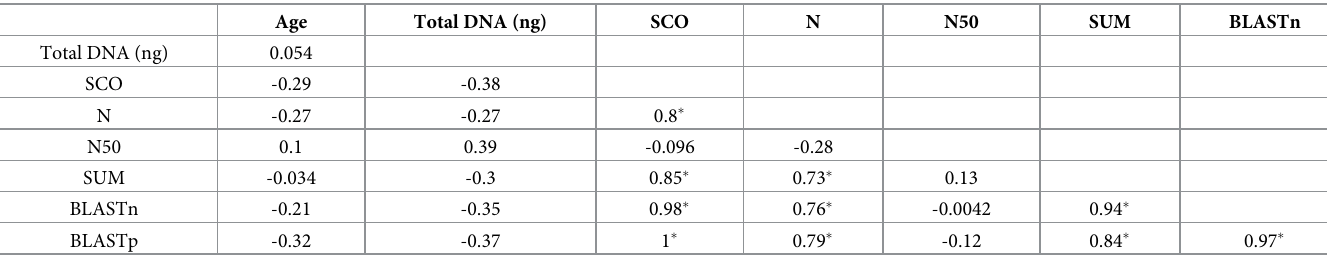
Table 6. Pearson correlations calculated between the